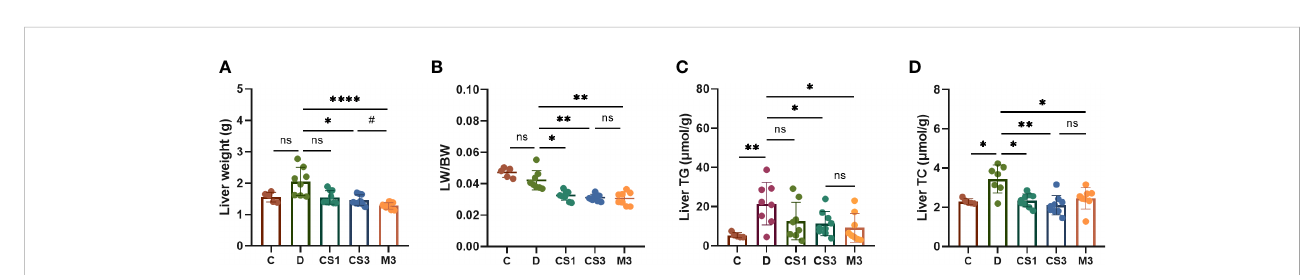
FIGURE 5 CS271011 decreased liver weight and improved hepatic biochemical indices. (A) Liver weight changes in the fi ve groups. (B) The ratio of liver weight to body weight; (C) Liver TG; (D) Liver TC. The results are expressed as the mean ± SD, *p < 0.05, **p < 0.01, and ****p < 0.0001 represent data vs. DIO controls; #p < 0.05 represent MGL-3196 3 mg/kg group vs. CS271011 3 mg/kg group; ns, not signi fi cant. C, chow diet control group (n=5); D, DIO control group (n=8); CS1, CS271011 1 mg/kg group (n=9); CS3, CS271011 3 mg/kg group (n=9); M3, MGL-3196 3 mg/kg group (n=8); LW, liver weight; BW, body weight.